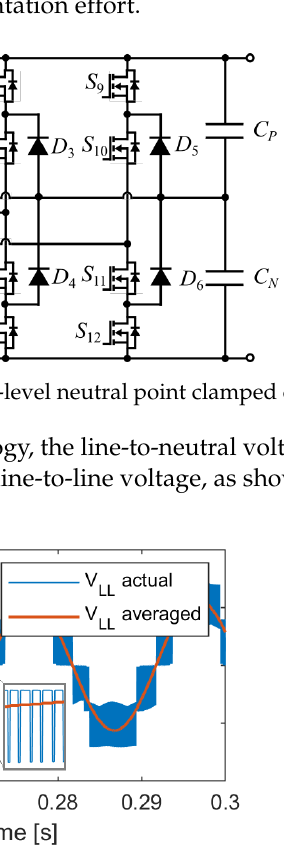
Figure 12. Three-phase three-level neutral point clamped rectifier simulation results: line-to-line voltage.